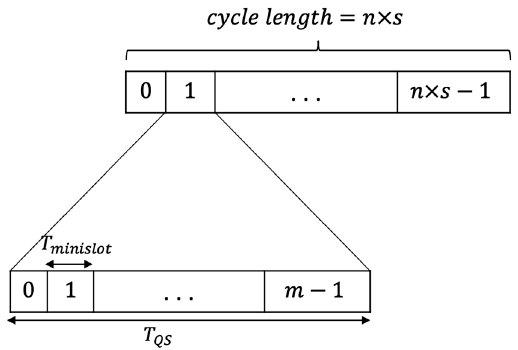
Figure 4. The quorum slot